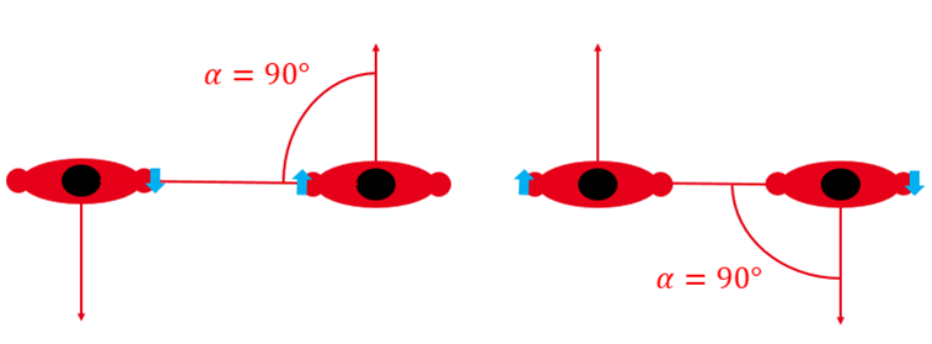
Figure 8. LOS position on the left and body-shadowed position on the right with the same reciprocal orientation angle.